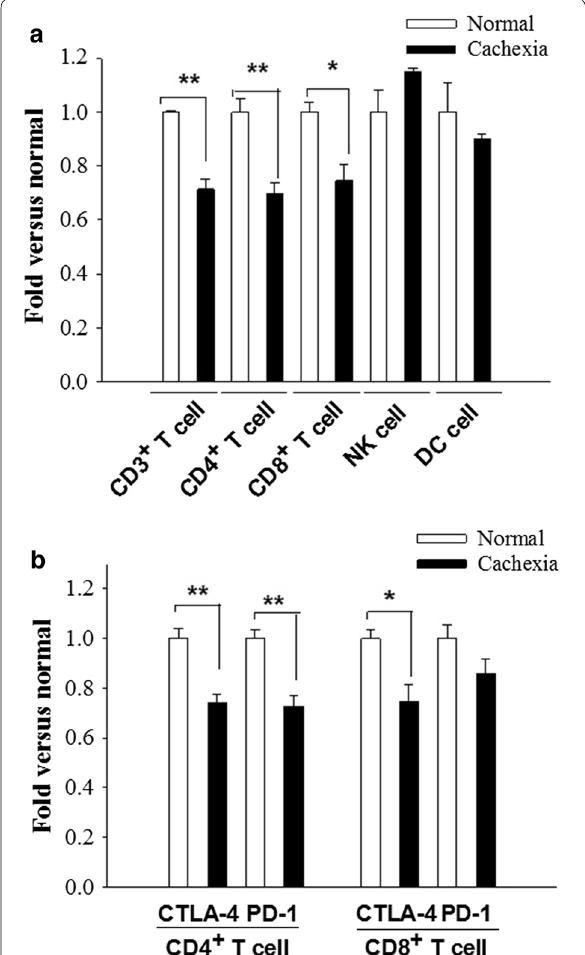
Fig. 2 Cachectic immunological changes in refractory cachexia. At 23 days from C26 cell inoculation, all mice were sacrificed and their spleen was extracted. a Populations of immune cells including CD3 + , CD4 + , CD8 + , T cells, NK cells and DCs. b Immune checkpoint molecules in spleen including CTLA‑4 and PD‑1 were analyzed by flow cytometry. The bar graph represents the fold‑change values of the cachexia group versus the normal group, with standard error of the mean.* P < 0.05, ** P < 0.01 versus control. NK, natural killer; DC, dendritic cell; CTLA, cytotoxic T‑lymphocyte‑associated antigen‑4; PD‑1, programmed cell death protein